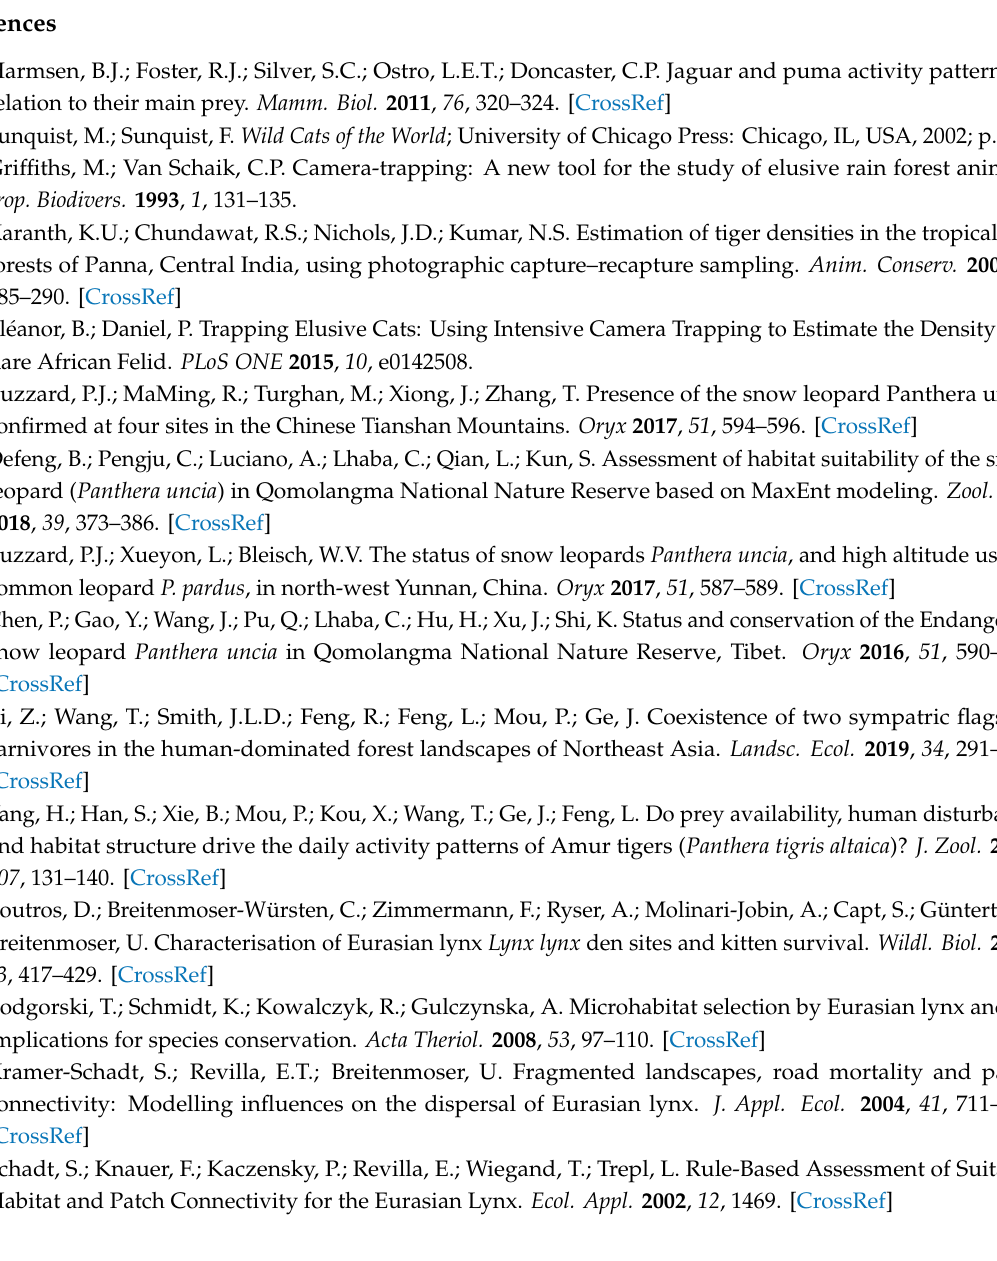
Figure S1: Six photos showing the inner side of forelimbs. ( a ) Two black dots on left forelimb; ( b ) One bigger black dot on left forelimb; ( c ) No obvious dot on right forelimb; ( d ) Three heavy black dots on left forelimb; ( e ) “V” type black mark on left forelimb; ( f ) Three light black dots on left